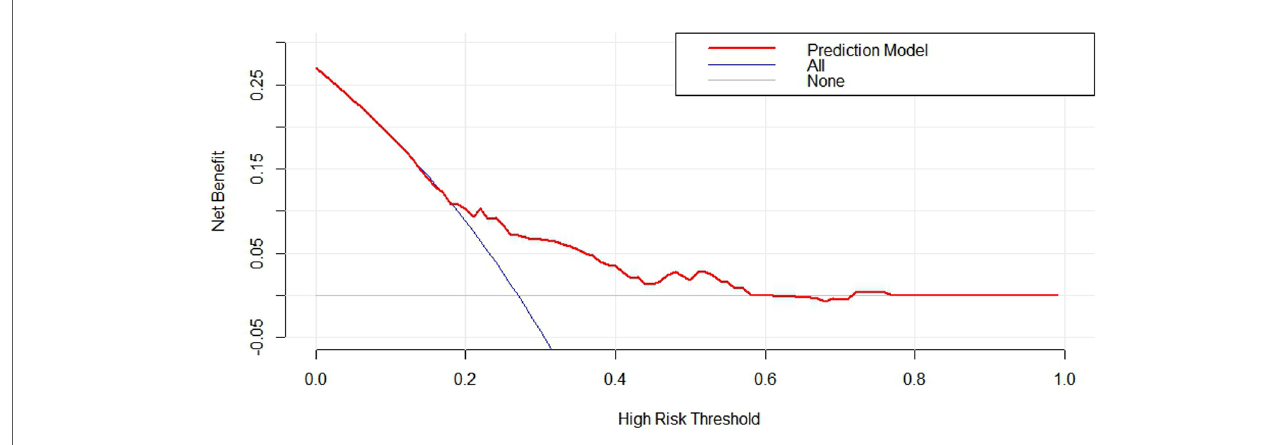
FIGURE 6 Decision curve for nomogram to predict the risk of anastomotic leakage before esophagectomy. The blue line assume all patients have AL. The gray line assume no patients have AL. The red curve represent clinical bene fi ts of patients at different risk levels of